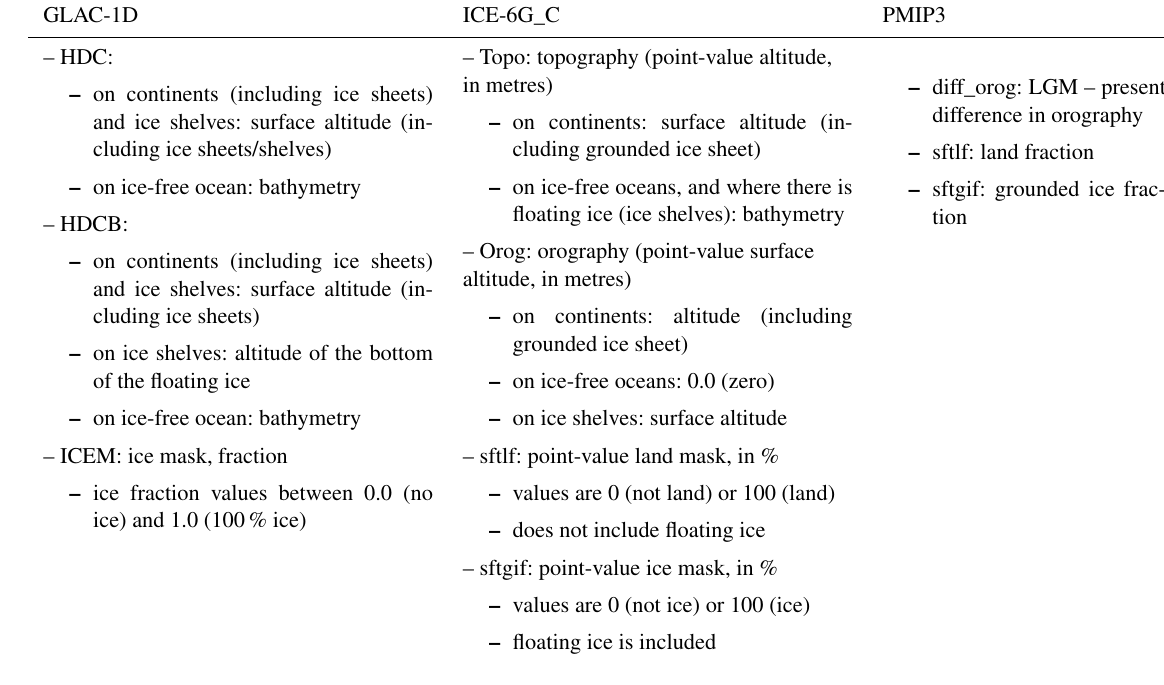
Table 2. Variables provided with the ice-sheet reconstructions considered for PMIP4.